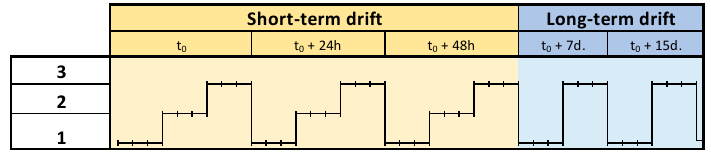
Figure 2. Experimental design considered for the evaluation of accuracy and drift of Cairsens NO 2